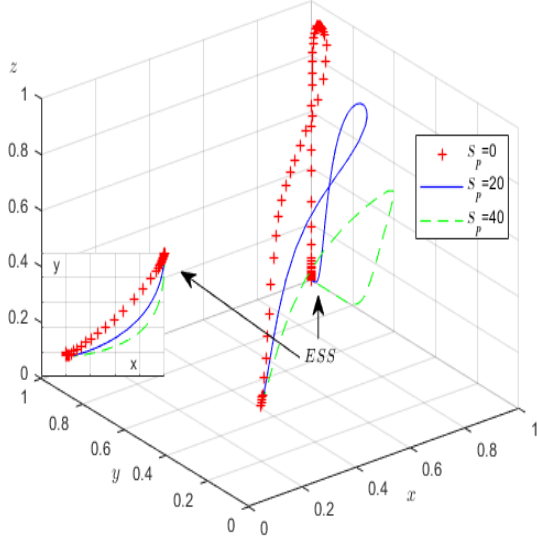
Figure 12. The influence of S p on evolutionary processes.